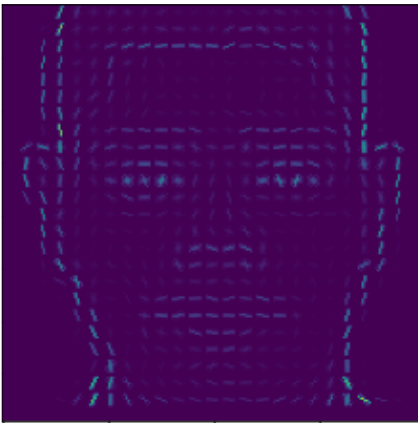
Figure 8. Gradients obtained by the HOG